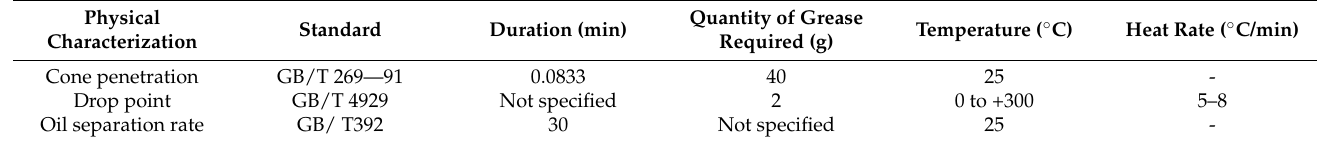
Table 1. Test conditions used for physical properties of grease